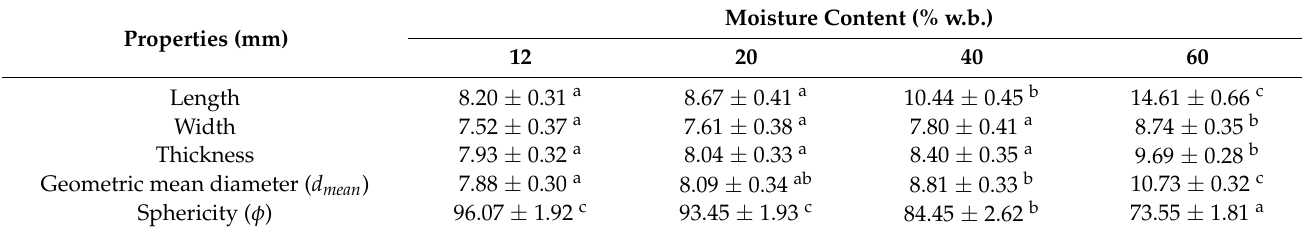
Figure 6. Shape and size changes of soybeans by moisture content. Table 1. Sizes of soybean grains with various moisture content.